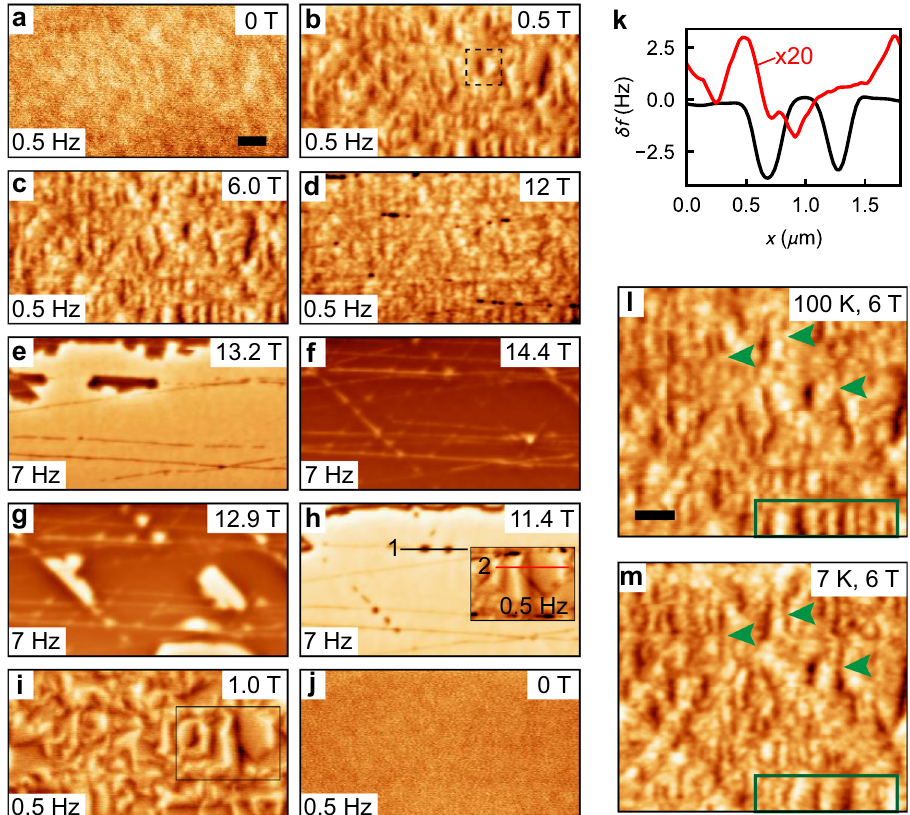
Fig. 4 Magnetic images of surface phase separation. a – j MFM images taken on a fl at region in different magnetic fi elds at 100 K, with the color scales labeled. The dashed rectangle in b contains a pair of dark and bright contrast. The inset in h shows the area with a reduced color scale (0.5 Hz) to highlight the weakly magnetic features. Scale bar in a : 1 μ m. Image size: 11 × 6 μ m 2 . k The line pro fi les taken along the two lines marked in h . The data for the red line is multiplied by a factor of 20. l – m A zoom-in view of the patterns after the sample is cooled down to 100 K ( l ) and 7 K ( m ) in different thermal cycles. Scale bar in l : 1 μ m. Image size: 7 × 6 μ m 2 . A magnetic fi eld of 6 T is later applied to enhance the contrast. The arrows and frames indicate the changes of the